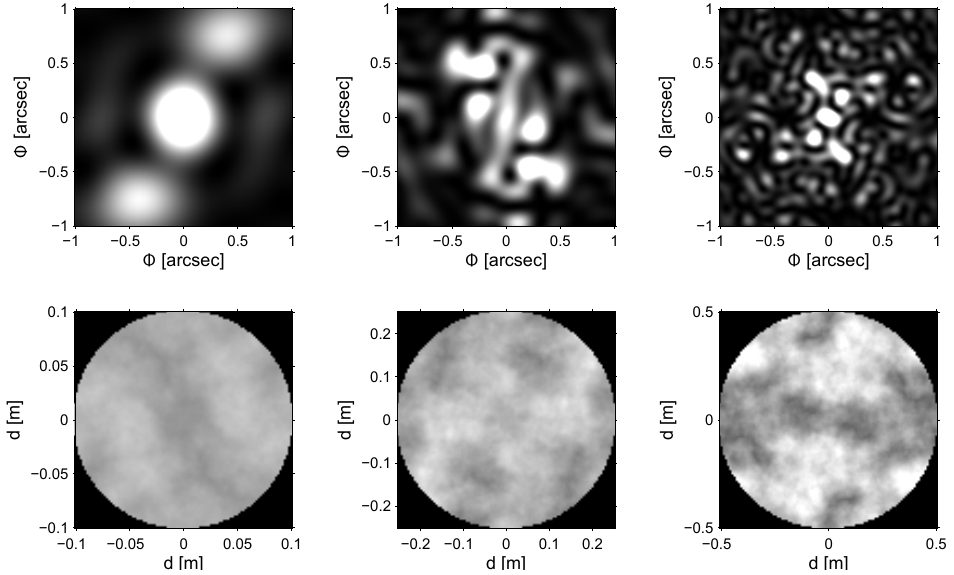
Figure 3. Simulated images ( top ) and the corresponding wavefront distortions ( bottom ) in observa- tions of point sources using telescopes with diameters of 0.2 m, 0.5 m and 1.0 m ( Φ —the observed angular area). The images correspond to very short exposure times (i.e., below the time constant of atmospheric coherence). The wavefront images use a greyscale in which the colours white and black correspond to phase shifts of 0 and 2 π ,